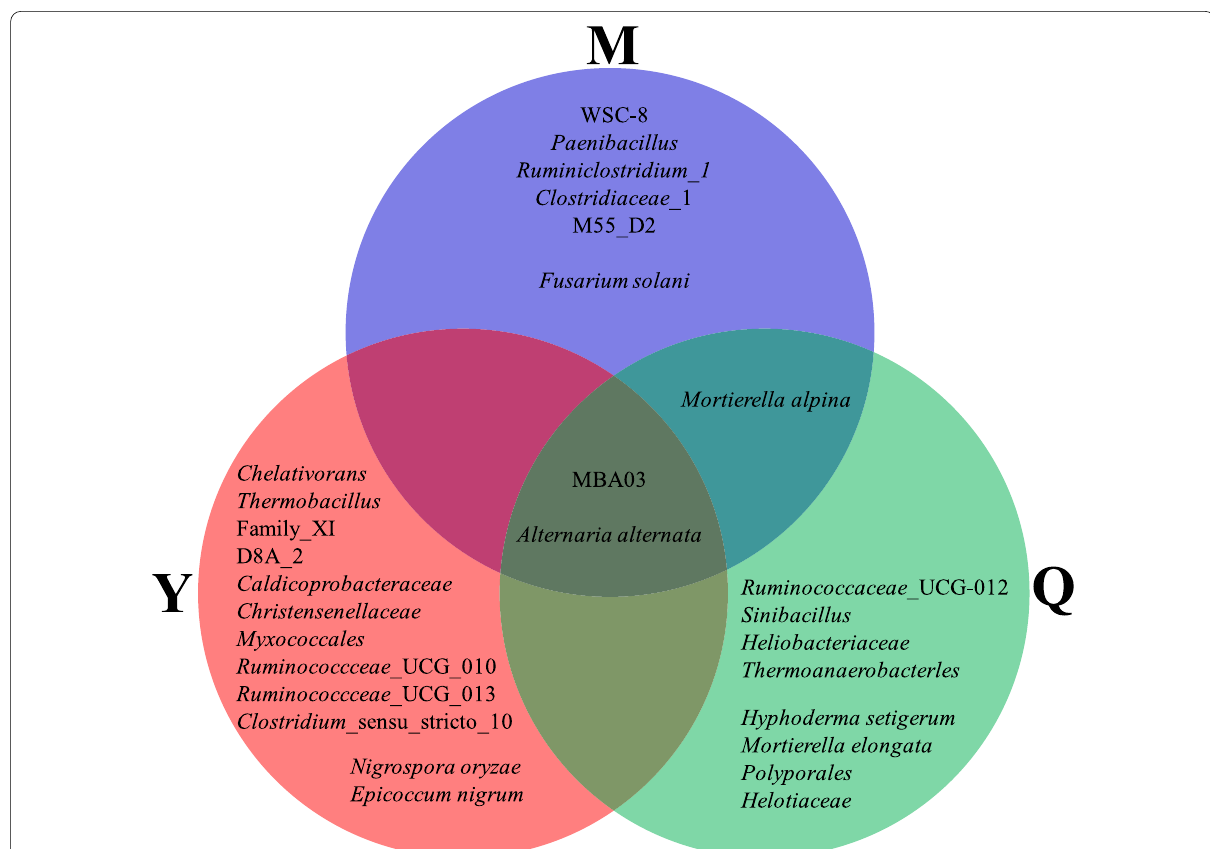
Fig. 6 Dominant and enriched species with a lignocellulosic degradation ability among the three bacterial communities. M, microbial consortia source from MC1; Q, microbial consortia source from MC1, sheep, and cattle feces; Y, microbial consortia source from sheep